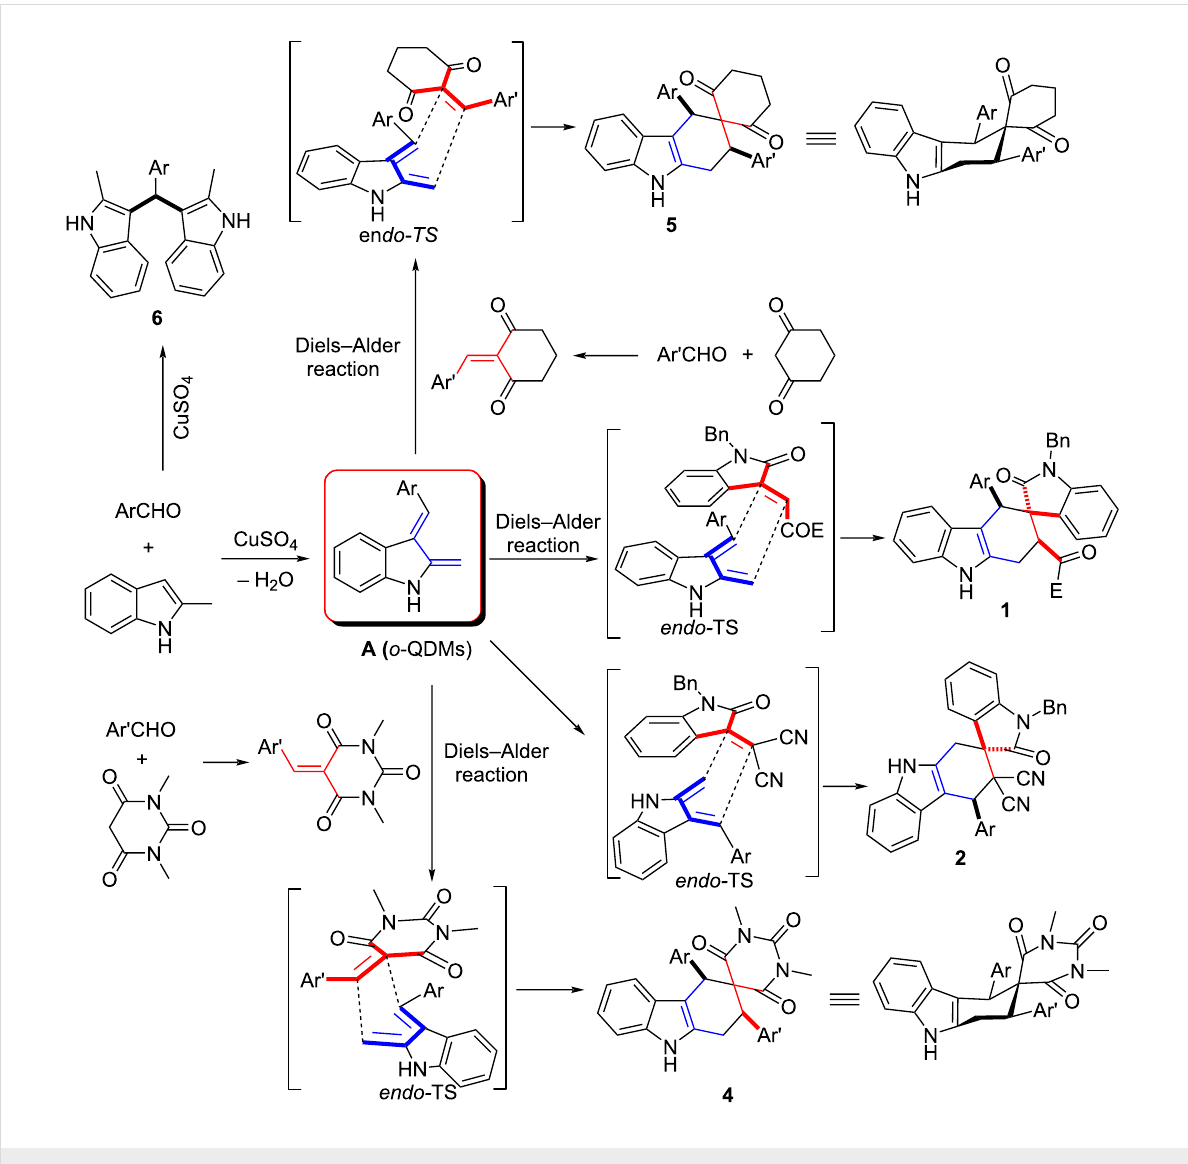
Scheme 7: Proposed reaction mechanism for the multicomponent